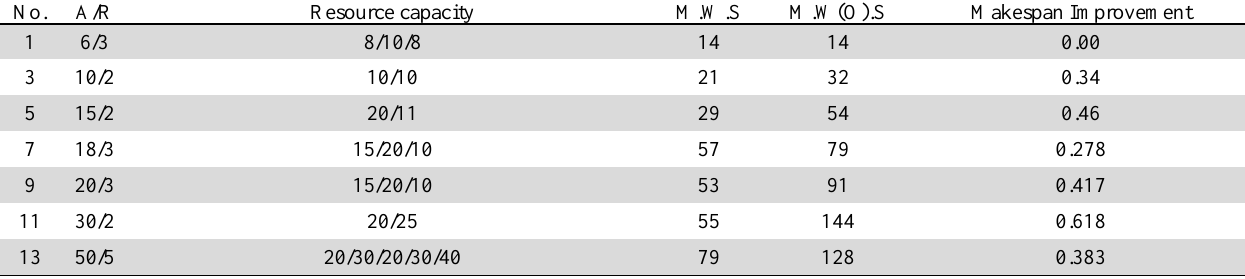
Results of Comparing BFSM-GA with Serial Programming